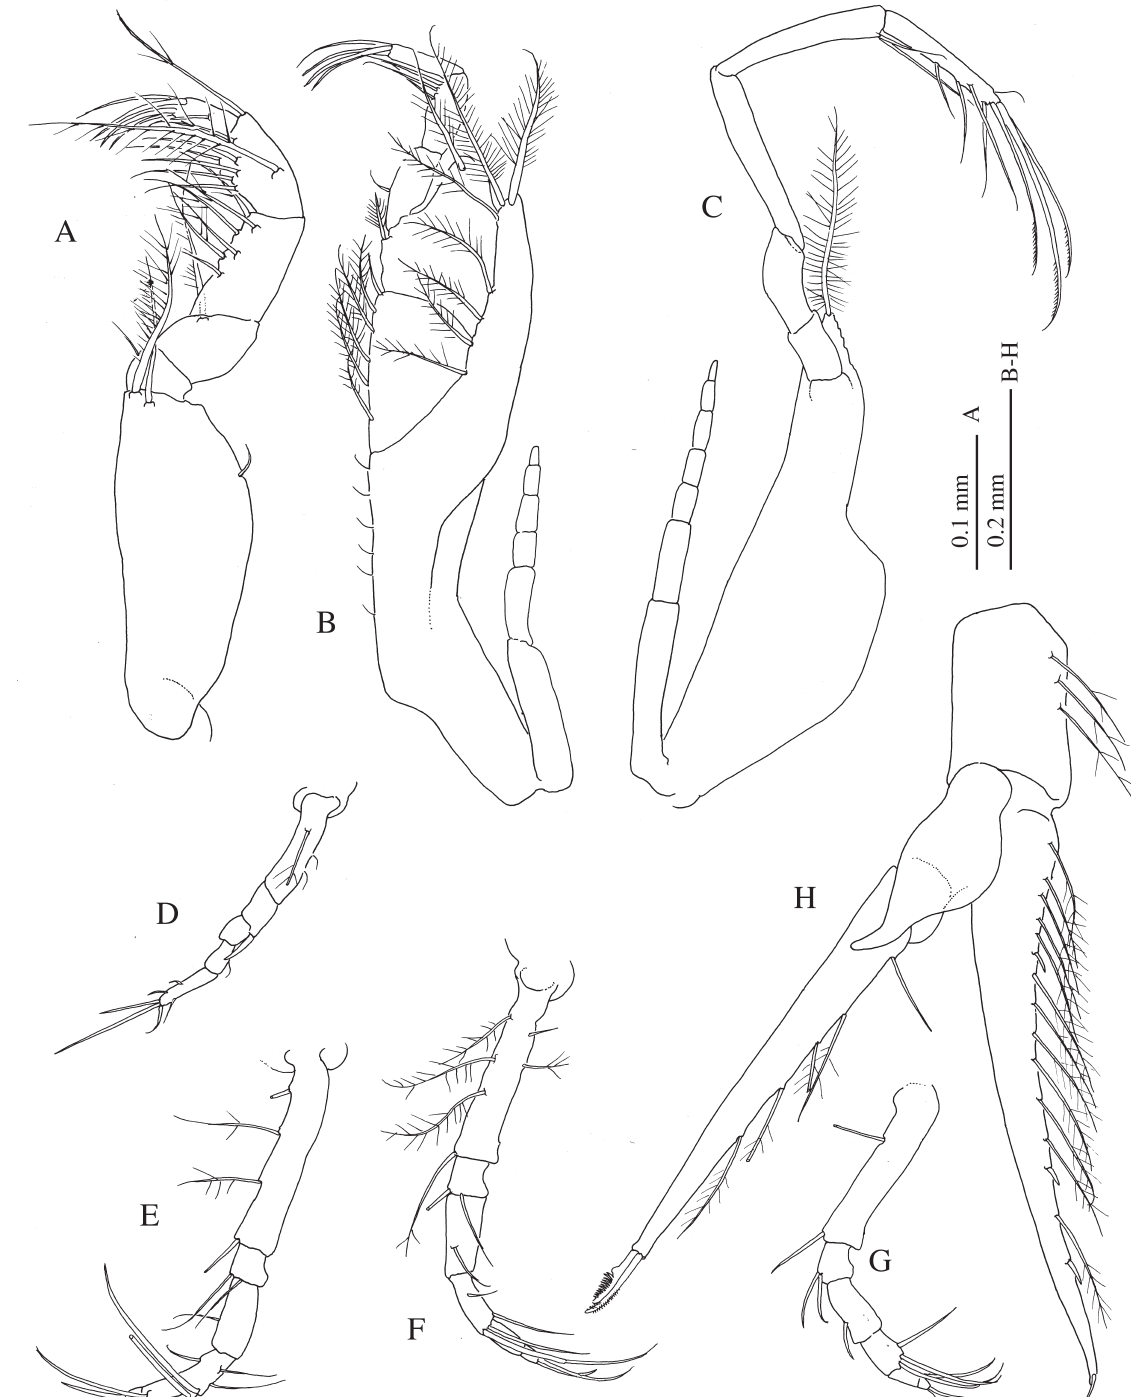
Fig. 4. – Eocuma rosae sp. nov., preadult female, paratype: A, maxilliped 2; B, maxilliped 3; C, pereopod 1; D, pereopod 2; E, pereopod 3; F, pereopod 4; G, pereopod 5. Adult female, holotype: H, left carinocurvum . All these species have the anterolat- (1983) described two additional species with the eral margin produced forward near the same features, E. striatum and E. sanguineum, from pseudorostrum, sometimes reaching its tip, forming the coasts of India. Recently, Corbera et al. (2005) an additional pair of projections. Eocuma rosae n. described another species from the Persian Gulf, E.